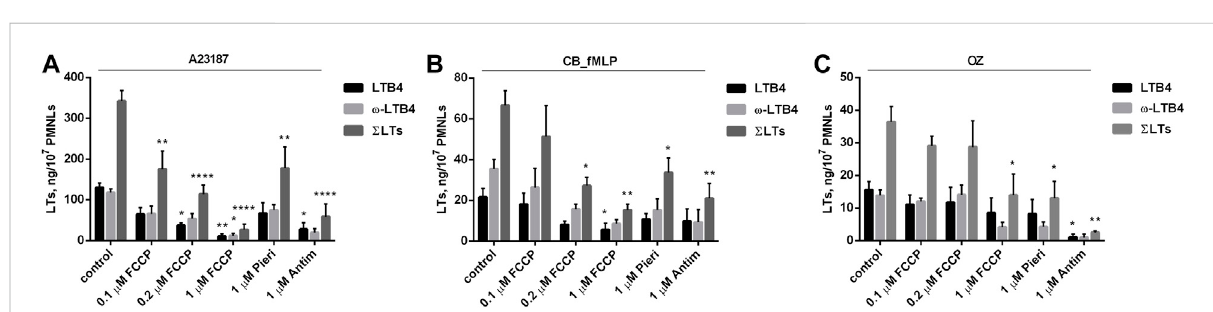
FIGURE 4 Effect of FCCP, Piericidin (Pieri) and Antimycin A (Antim) on leukotriene synthesis inhuman neutrophils. Before treatment, PMNLs (1 – 1.2) × 10 7 / 6 ml were pre-incubated for 10 min at 37 ° C at CO 2 incubator. Then cells were treated 30 min with reagents indicated on X -axis. After that, A23187 (1 µM) (A) , or cytochalasin B (5 µM) (B) or OZ (0.04 mg/ml) (C) were added for 10 min, then fMLP (0.1 µM) for 10 min (B) , as indicated. Values present mean ± SEM of three or more independent experiments performed in duplicate. The 5-LOX products were analyzed using HPLC, and data